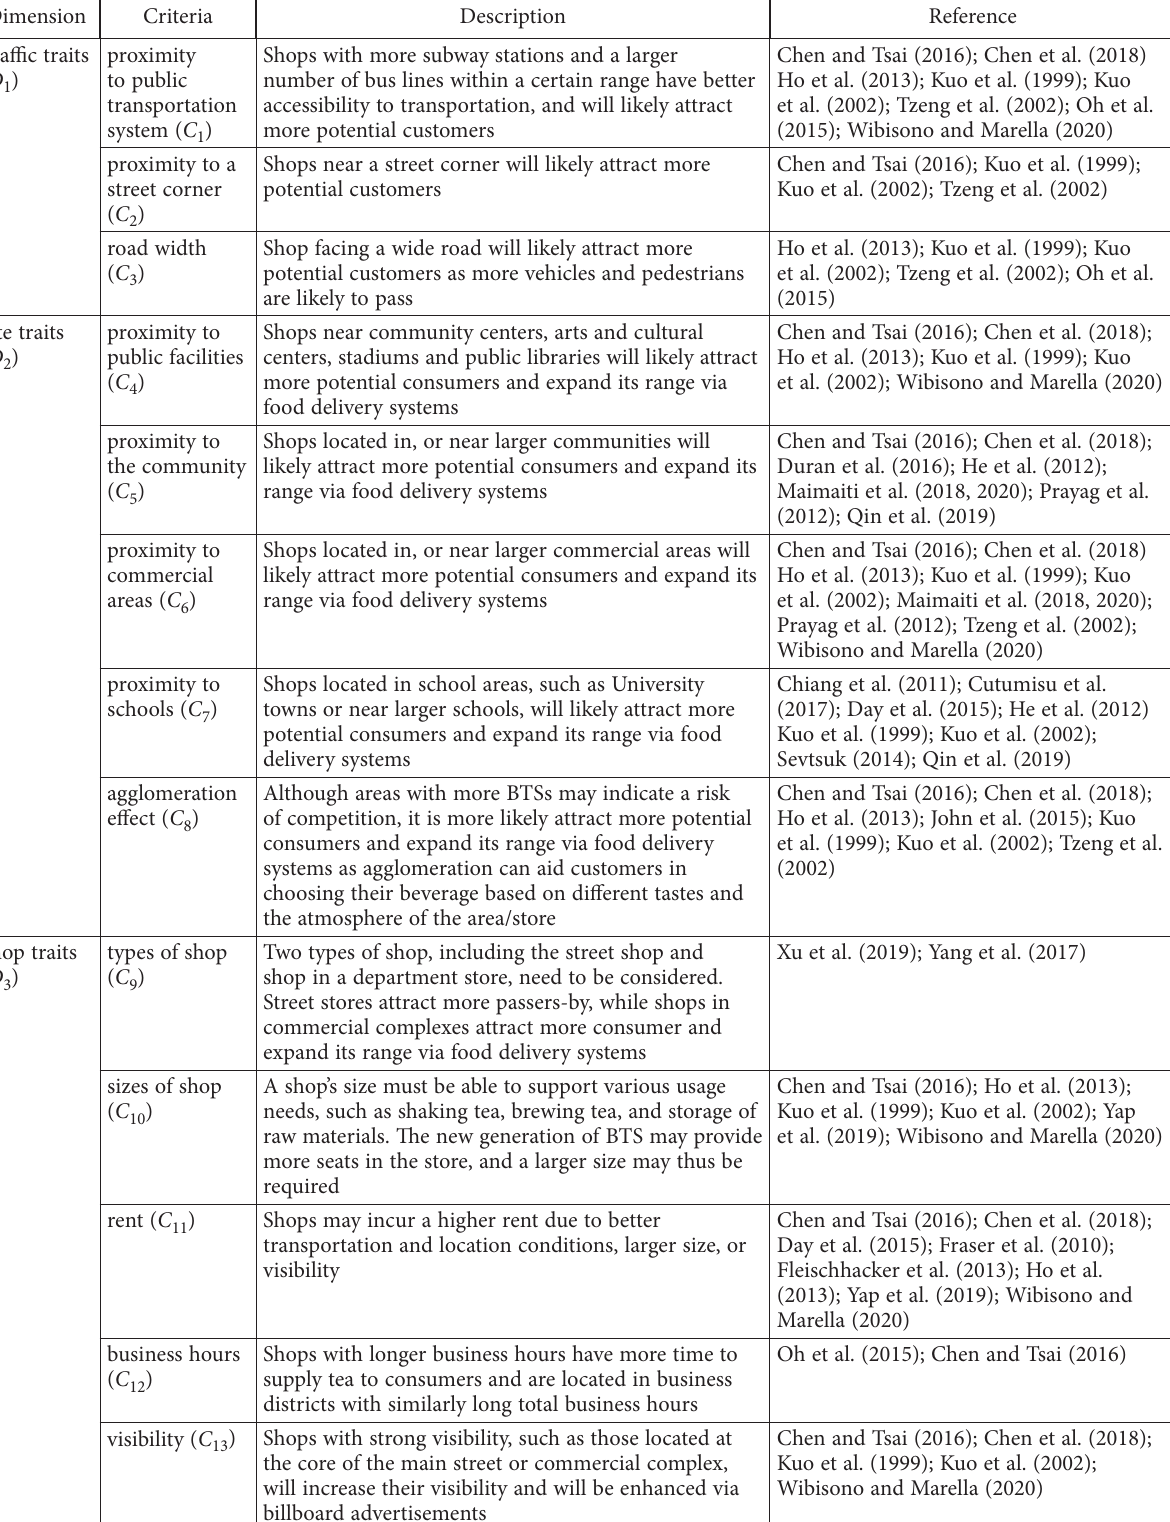
Table 1. Proposed dimension/criteria for location determinat ions of BTS Dimension Criteria Description